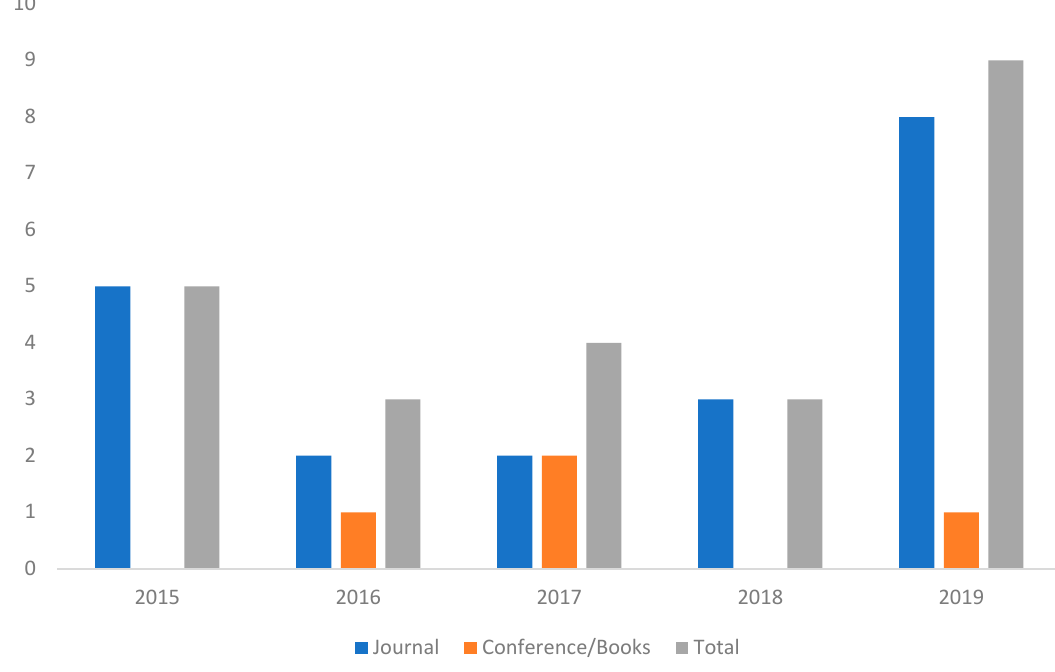
Figure 8. Evolution of the articles published in the last 5 years.